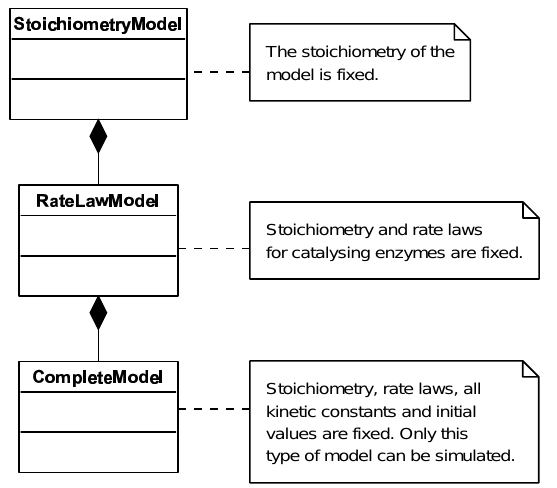
Figure 2: UML class diagram of the hierarchical structure of the model repository. Each stoi- chiometry model can be reused within several rate law models and each rate law model can be reused within several complete models. Only the complete models at the bottom can be simulated within Gepasi or